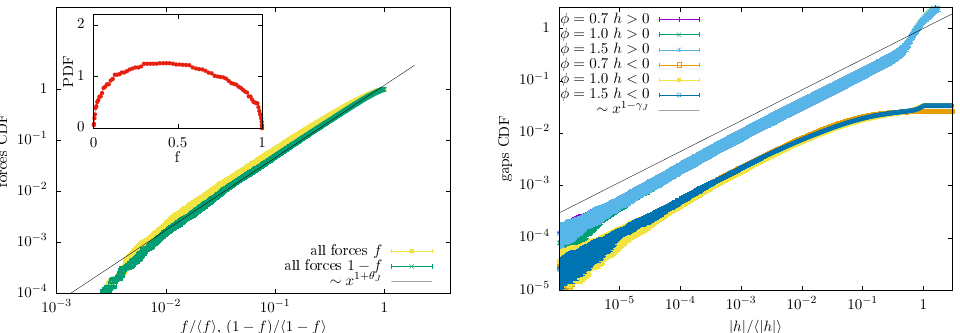
Figure 9: Left panel : Cumulative distribution of contact forces close to the two edges at φ = 1.5. The solid line corresponds to the mean field theory prediction. In the inset we plot the corresponding empirical distribution function. Right panel : Cumu- lative distribution of small positive and negative gaps for different packing fractions. The solid line represents the mean field theory prediction. Data produced with sys- tem size N = 1024, dimensions d = 3, averaged over 45 samples for density φ = 0.7, 44 samples for φ = 1.5, 27 samples for φ =